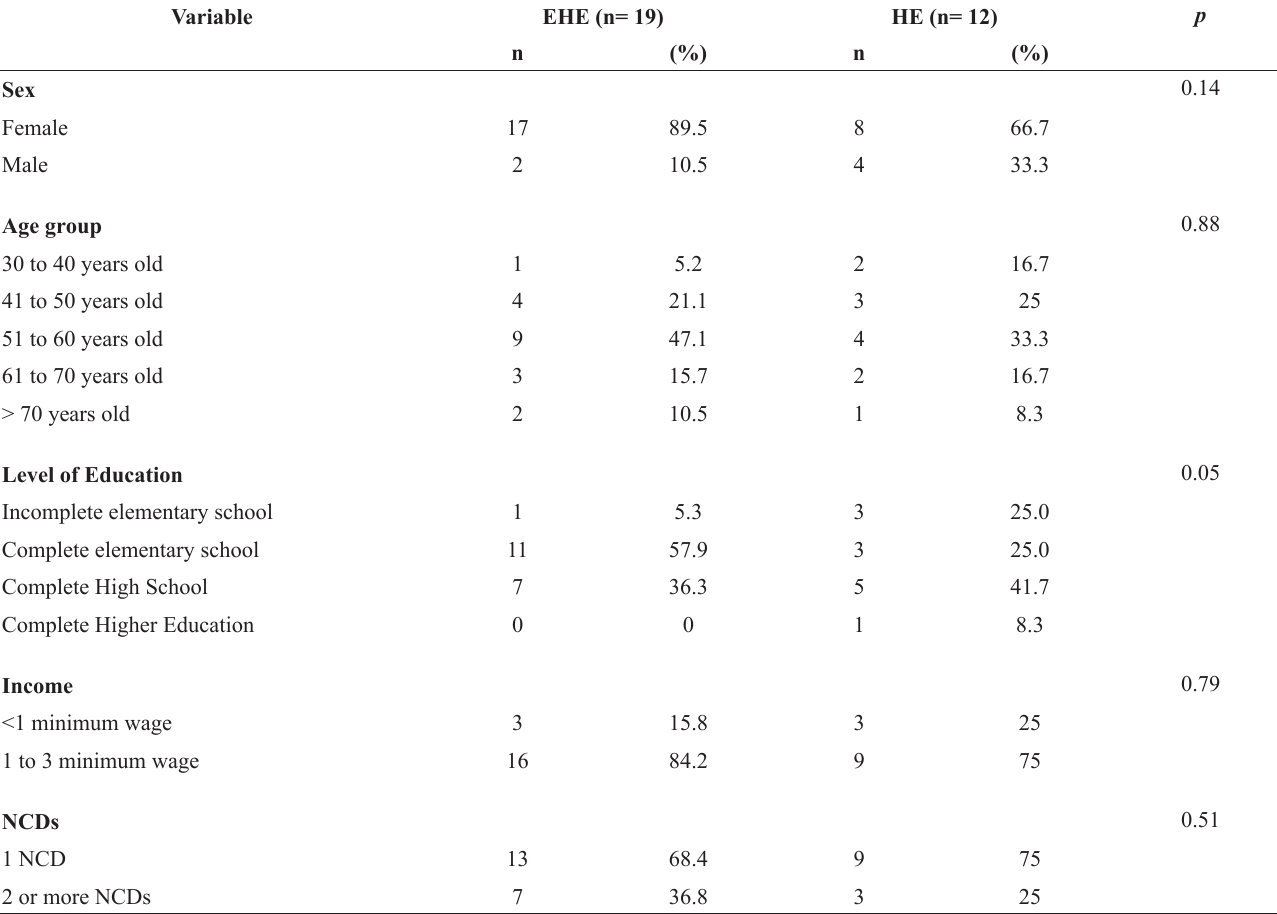
Table 1 - Sociodemographic profile of the participants in the Saúde Ativa